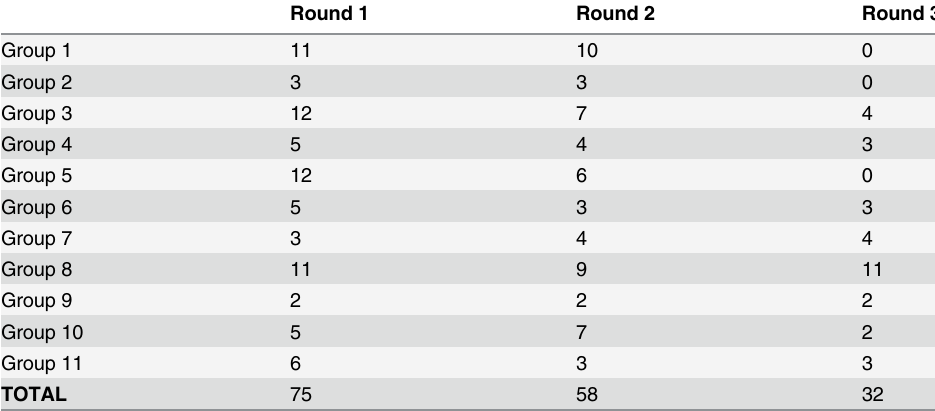
Table 2. Number of participants by group and data collection